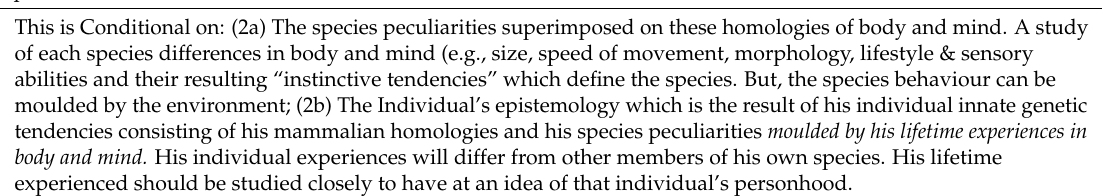
Table 3. The Conditional Anthropomorphic assessment of another mammal’s